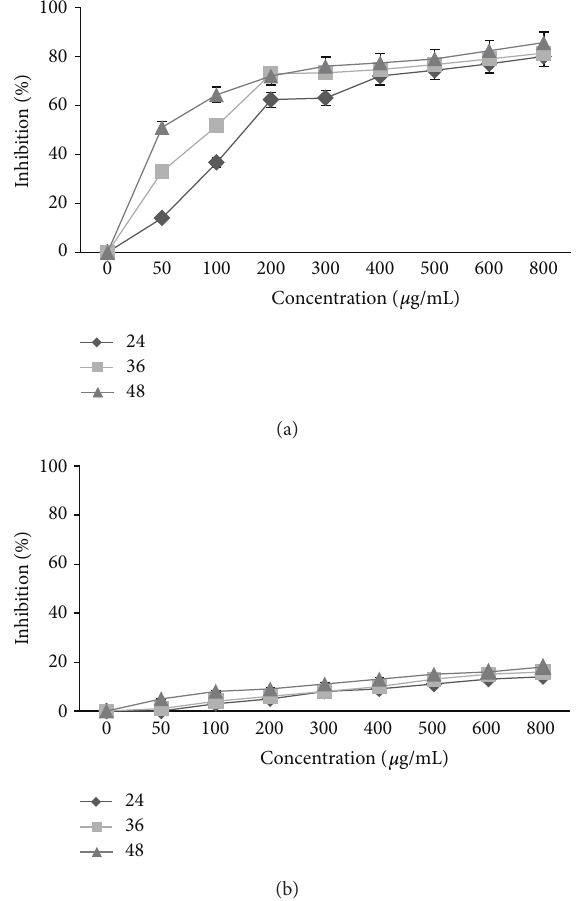
T 1: Comparison of cytotoxicity activity of (a) Toxol (Paclitaxel: plant-derived chemotherapeutic anticancer drug from Taxus brevi- folia L.) and (b) E. platyloba in 24h. Data presented are the mean SEM of three independent